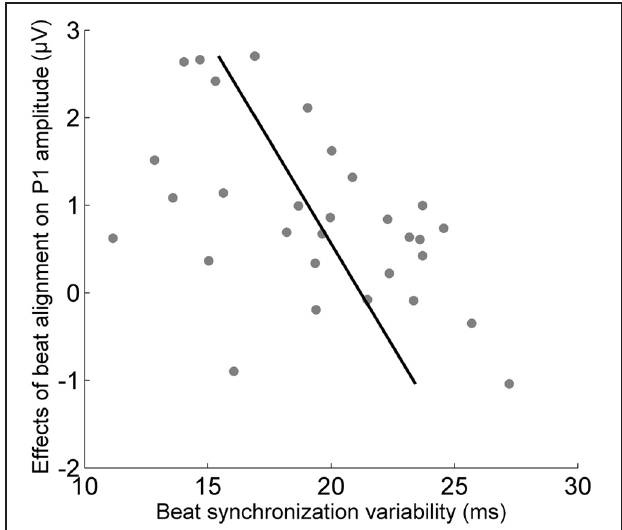
FIGURE 3 | Relationship between the cortex’s sensitivity to the musical beat and beat synchronization ability. The effect of the musical beat on the cortical response to sound relates to beat synchronization ability ( p < 0 .